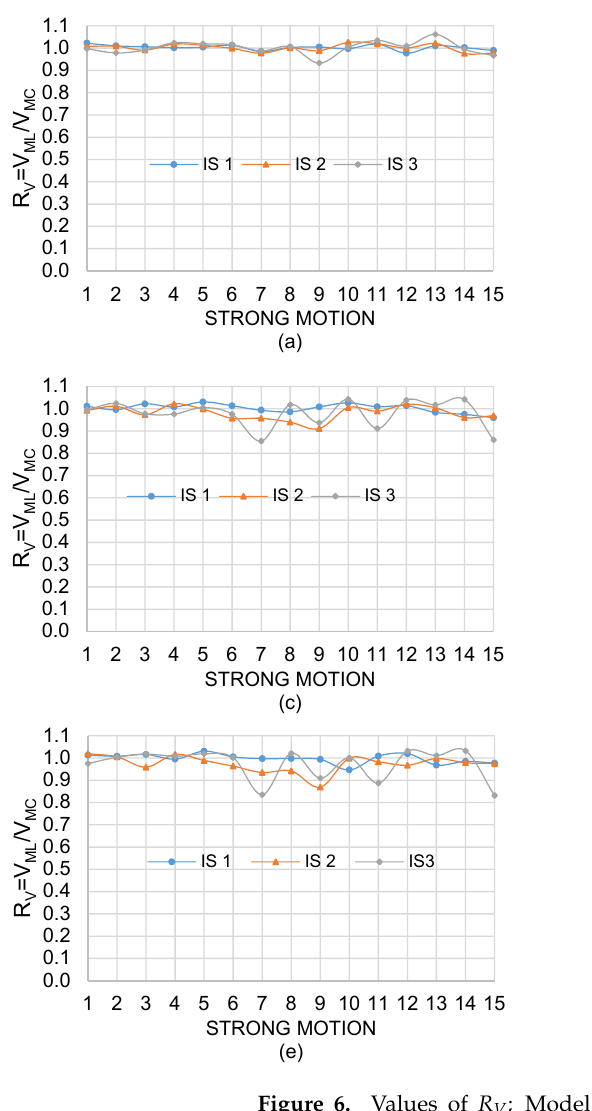
Figure 7. Mean values of R V ; ( a , b ) , NS - EW direction, respectively, Model 1; ( c , d ), NS - EW direction, respectively, Model 2; ( e , f ) , NS - EW direction, respectively, Model 3.